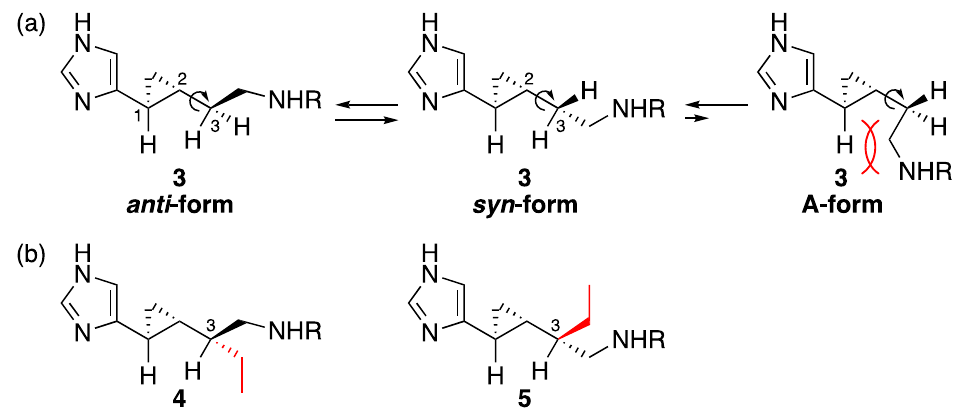
Figure 2. ( a ) The anti -, syn - and A-forms in 3 ; ( b ) The conformationally restricted histamine analogues 4 and 5 with cyclopropylic strain. R indicates a 4-chlorobenzyl group.